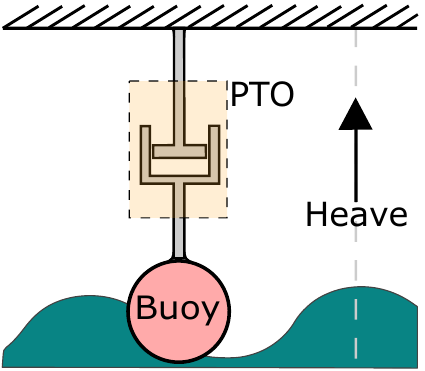
Figure 1. Illustrative scheme: point absorber wave (PAW) system of the W2POWER